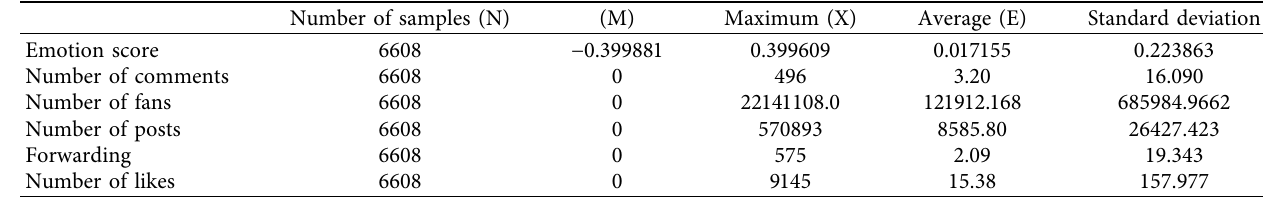
Table 2: Descriptive statistics.